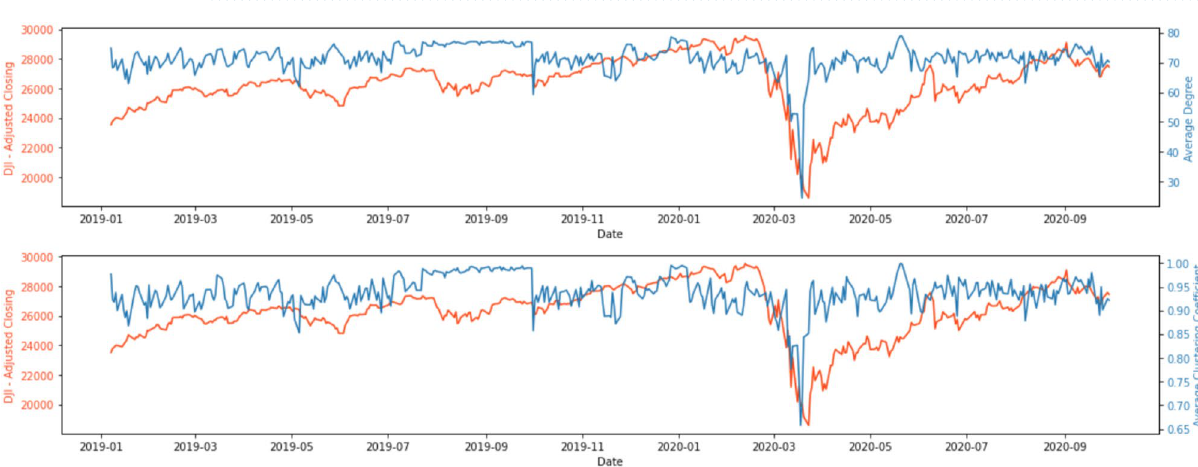
Figure 7. Comparison of network statistics with DJIA, 1 January 2019 to 30 September 2020.